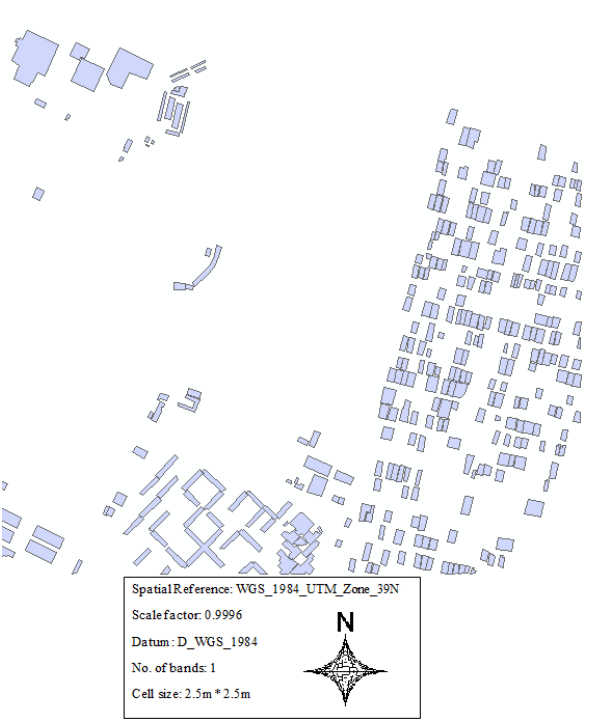
Figure 6. The buildings location in the city